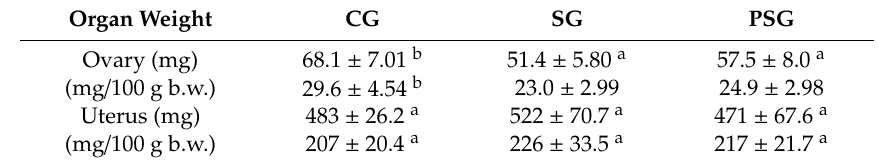
Table 2. Effect of frequent changes in diet or periodic starvation on rat ovary and uterus weights.